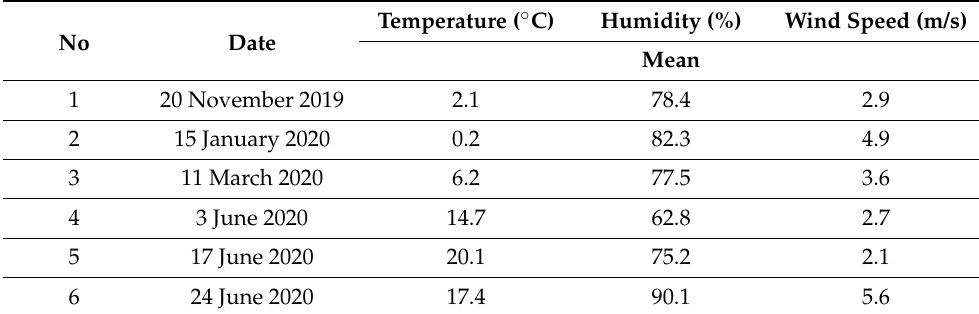
Table 2. Schedule of the measurement